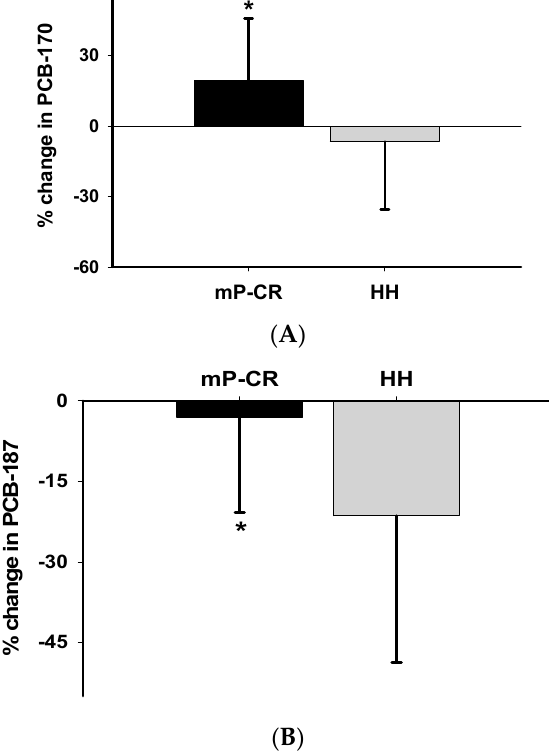
Figure 5. Percentage changes in PCB-170 ( A ) and PCB-187 ( B ) between mP-CR and HH groups following WM (Phase 2). * Significant group effect (mP-CR vs. HH; p < 0.05).